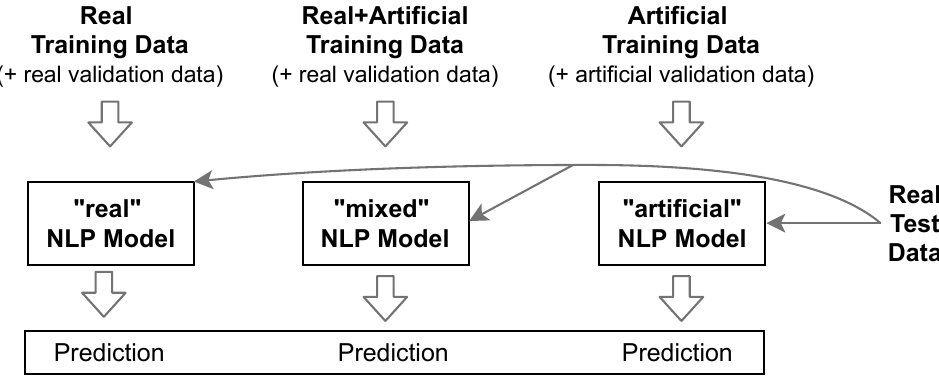
Figure 3. Overview of extrinsic evaluation procedure. We compare three settings: (1) a model trained on real data (baseline), (2) a “mixed” case, where we extend real data with synthetic data, and (3) only synthetic training data. All models were tested on real data (gold annotations). This evaluation setup extends Ive et al. [15] by step